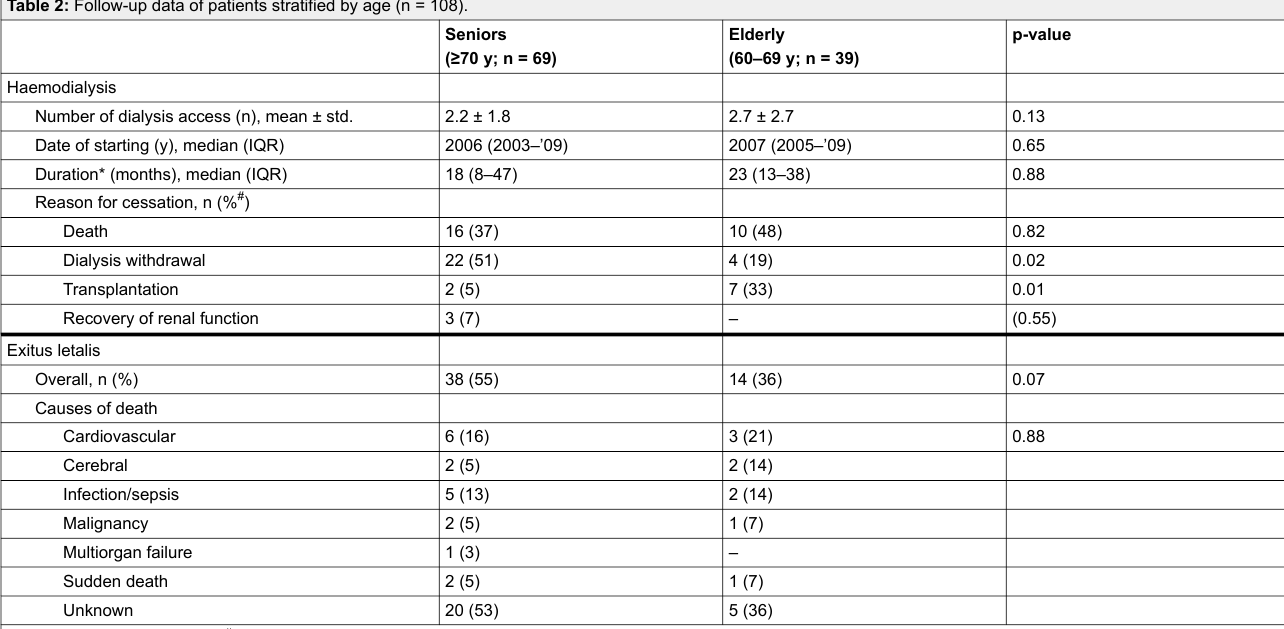
Table 2: Follow-up data of patients stratified by age (n = 108).